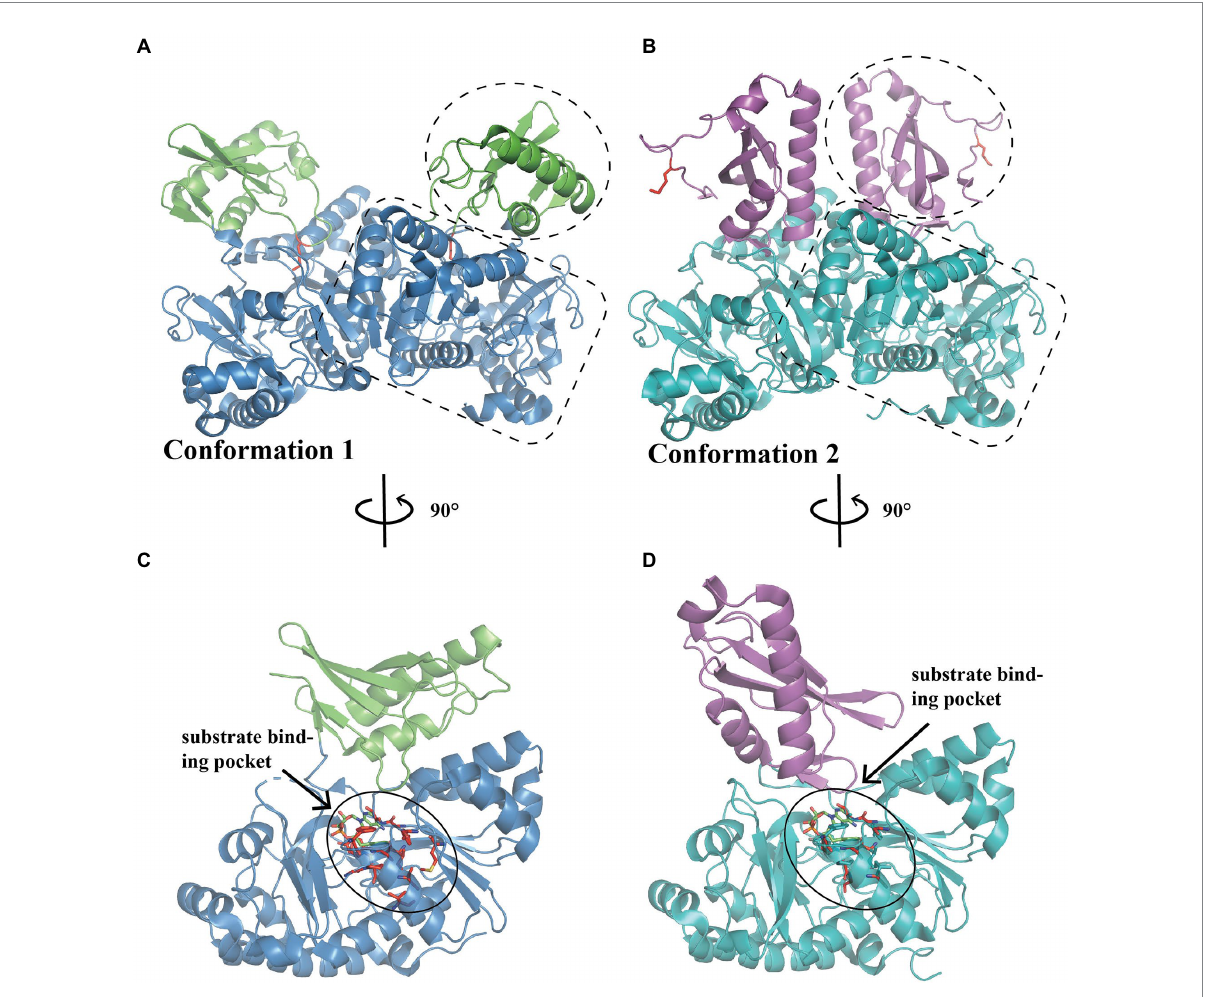
FIGURE 2 Overall structure of PaaK. (A) The overall structure of dimer BcePaaK1 (PDB: 2Y4N) in conformation 1. The N-terminal domain and C-terminal domain are circled by a dotted line in blue and green, respectively, the Lys422 at the active site is shown as sticks in the side chain in red. (B) The overall structure of dimer BcePaaK2 (PDB: 2Y4O) in conformation 2 with a similar N-terminal domain and a rotated C-terminal domain. The N-terminal domain and C-terminal domain are circled as in (A) in teal and magenta, respectively. The corresponding Lys429 is shown as in (A) . The PaaK co-structures with phenylacetyl-adenylate are captured in alternate conformations (C , D) . The residues involved in the binding pocket are shown as sticks in red and substrates are shown as sticks in